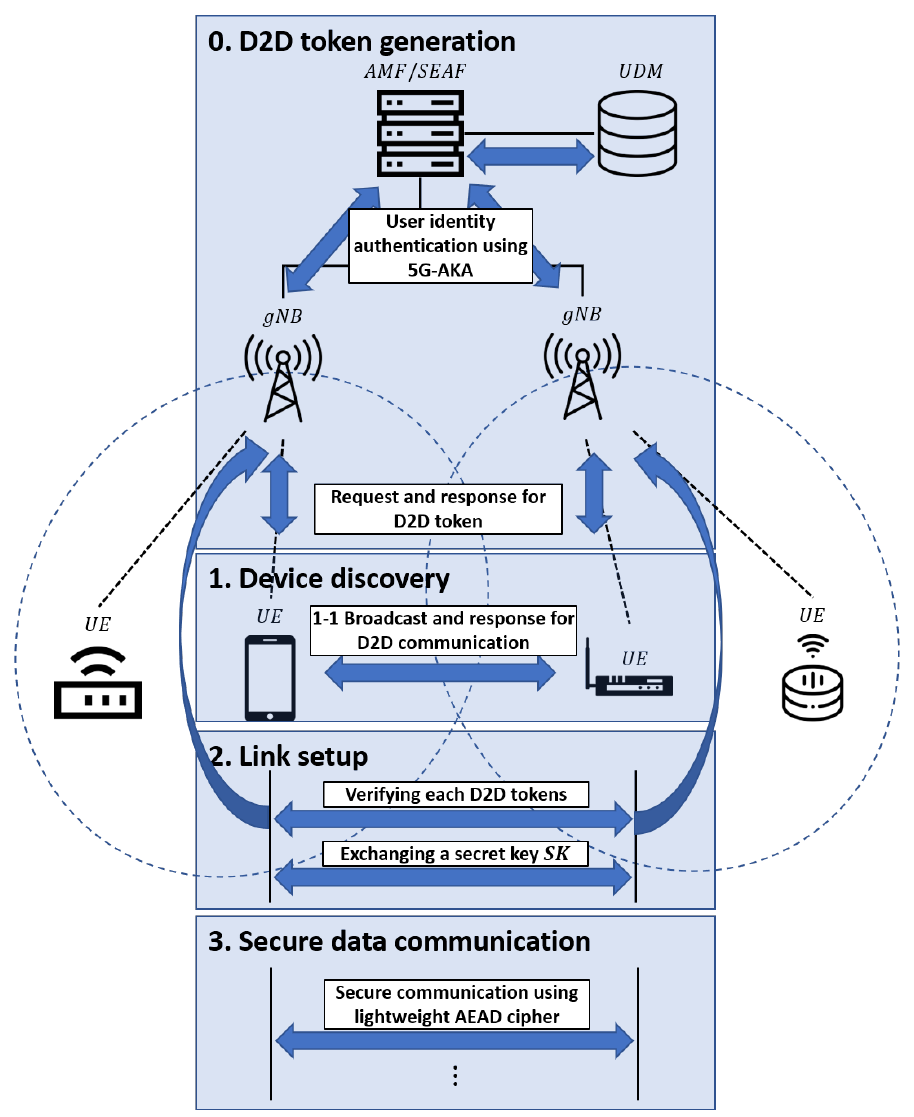
Figure 1. Secure D2D communication system model for a 5G Internet of Things (IoT)